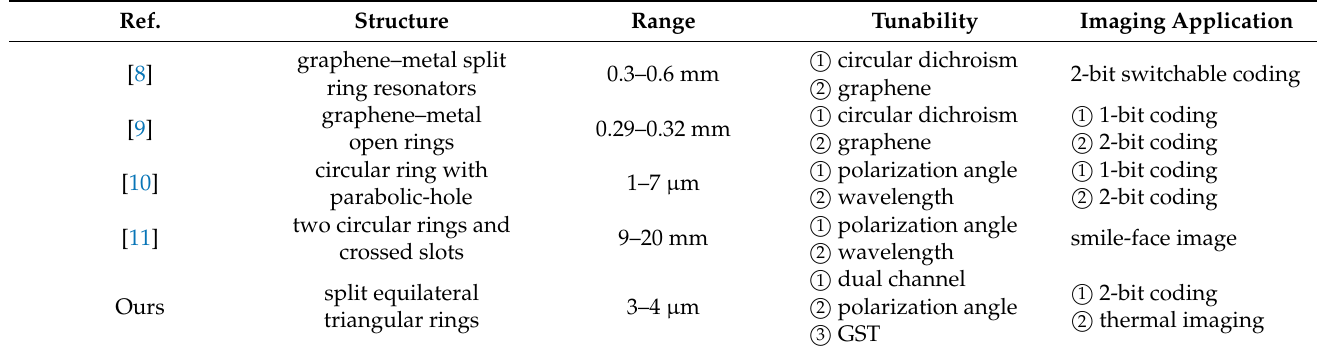
Table 1. Comparison of our work with analogous